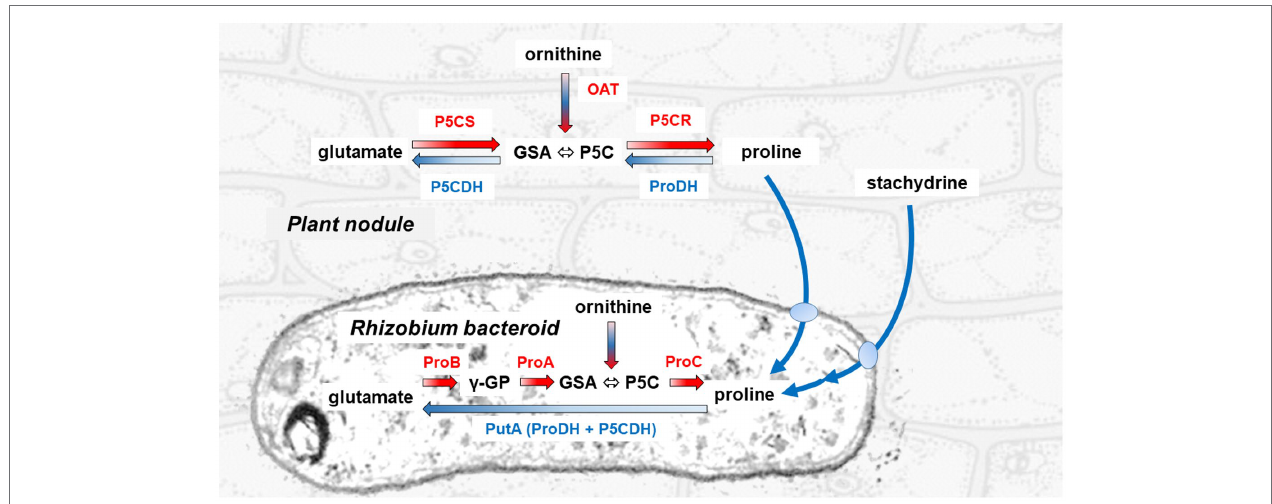
FIGURE 1 | Pathways for proline synthesis and catabolism in the legume plant and the rhizobial symbiont. The synthesis of proline proceeds in the cytoplasm of the plant cell through the sequential action of a bifunctional P5C synthetase (P5CS) that reduces glutamate to glutamate semialdehyde (GSA, which spontaneously cyclizes to P5C), and of a P5C reductase (P5CR) that reduces the latter to proline. In the bacteroid, the same initial reaction is catalyzed by two distinct enzymes, a γ -glutamyl-kinase (ProB) and a glutamyl-phosphate reductase (ProA). Conversely, proline is oxidized back to glutamate in the plant mitochondrion through two steps, catalyzed by a proline dehydrogenase (ProDH) that feeds electrons directly to the respiratory chain, and a P5C dehydrogenase (P5CDH). In the bacterial symbiont, these reactions are mediated by a single proline oxidase (PutA) bearing both catalytic domains of ProDH and P5CDH. GSA/P5C is generated also during arginine catabolism by means of an ornithine- δ -aminostransferase (OAT). Utilization of stachydrine, also known as proline betaine, a compatible osmolyte that is accumulated in several legumes under stress, proceeds in the rhizobium by means of some proline-releasing enzymatic activities, whose genes are grouped on the Sym plasmid (Goldmann et al.,